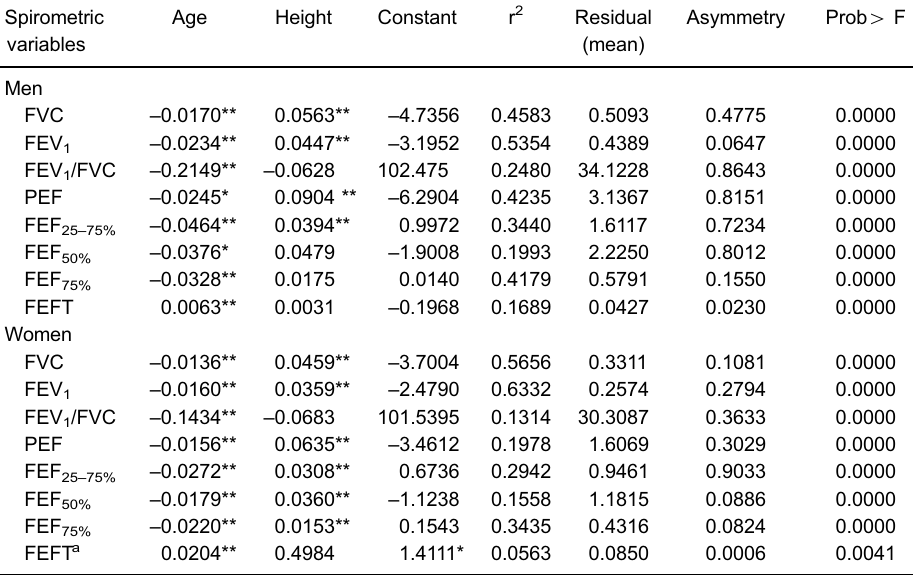
Table 3. Equation coef fi cients for spirometric variables for men and